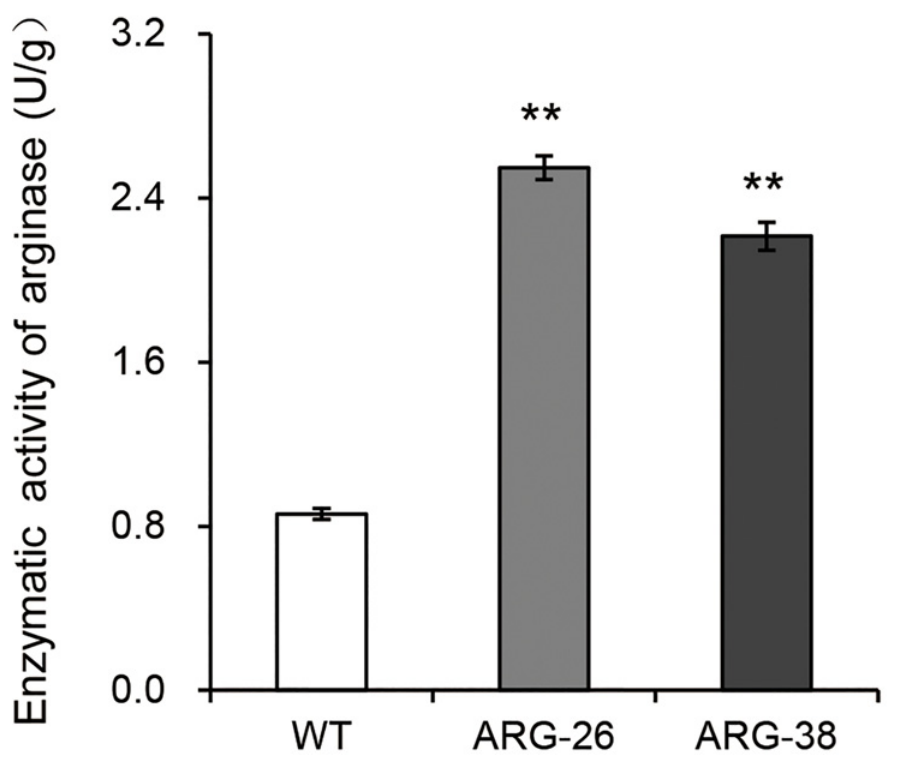
Fig 5. Arginase enzyme activity in ARG-26 and ARG-38 transgenic cotton leaves. Compared with arginase activity of non-transgenic control plants, expression of OsARG increase the total arginase activity in ARG-26 and ARG-38. ‘ WT ’ refers to non-transgenic control plants of wild type cotton. ** : P < 0.01.